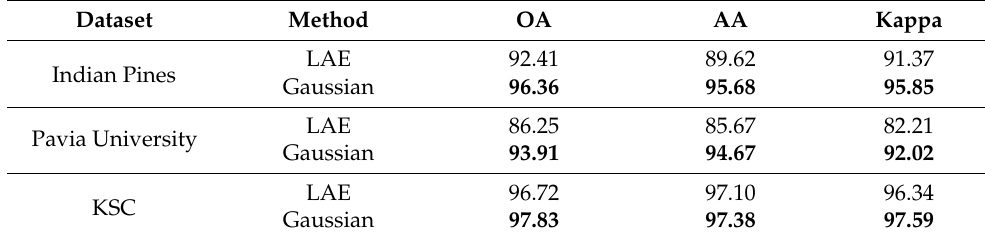
Table 5. The classification accuracy of the two methods to solve the matrix P in the three datasets.